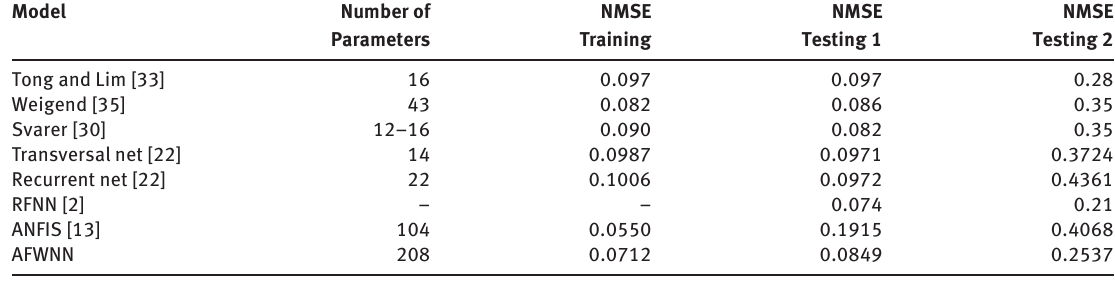
Table 2. Comparison of Different Models for Sunspot Time Series Prediction. Model